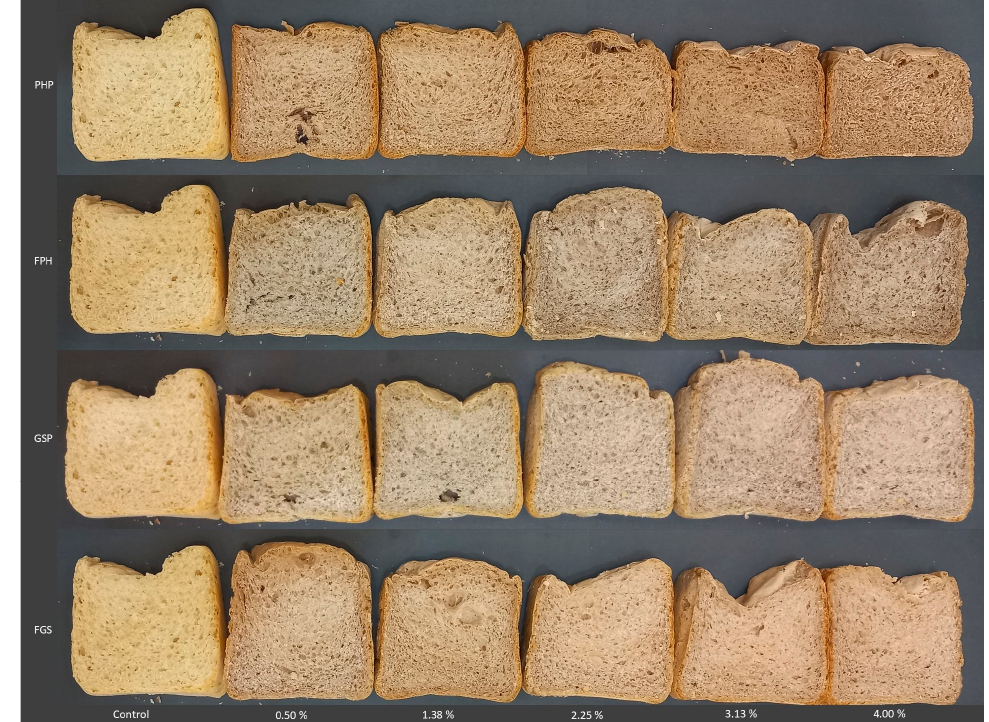
Figure 4. Picture of control and enriched breads. The highest score for the crust and crumb color was obtained by the control bread, and the lowest by the bread with PHP, which was consistent with the results of the color analysis. The results show that the breads that contained pistachio hulls had lower scores compared with the other breads. This may be attributed to the lower brightness of the bread and the higher redness, which may have had a negative effect on the color perception of the panelists. The crust color evaluation was not affected by the type and level of additives, while the crumb color evaluation was affected by the type and ratio of additives (Figure 5a,b). Moreover, it was found that the crust and crumb color scores for all enriched breads (except for bread with 0.5% and 4% additions of GSP and FGS) were different from those of the control bread ( p < 0.05). No significant difference was found between the control sample and the enriched breads in terms of chewiness. The lowest chewiness score was found for the bread with 1.38% GSP and the highest was found for the bread with 4% PHP (Figure 5c). Flavor and taste scores were also not influenced by the type and level of additives (Figure 5d,e). The lowest flavor and taste scores were obtained for the breads with PHP; however, the control and all enriched breads did not differ significantly in their flavor and taste scores. Consequently, with a PHP level of 4% in the bread recipe, the flavor and taste scores of the bread were below 4 points. The highest score for overall liking was given to the control bread, and the lowest to the bread with PHP, as well as for all other sensory characteristics tested (with the exception of chewiness). Nevertheless, the control bread and all the enriched breads differed significantly in the overall liking score (except for the breads with 0.5% and 4% added GSP and FGS). The overall liking score was only affected by the type of additive (Figure